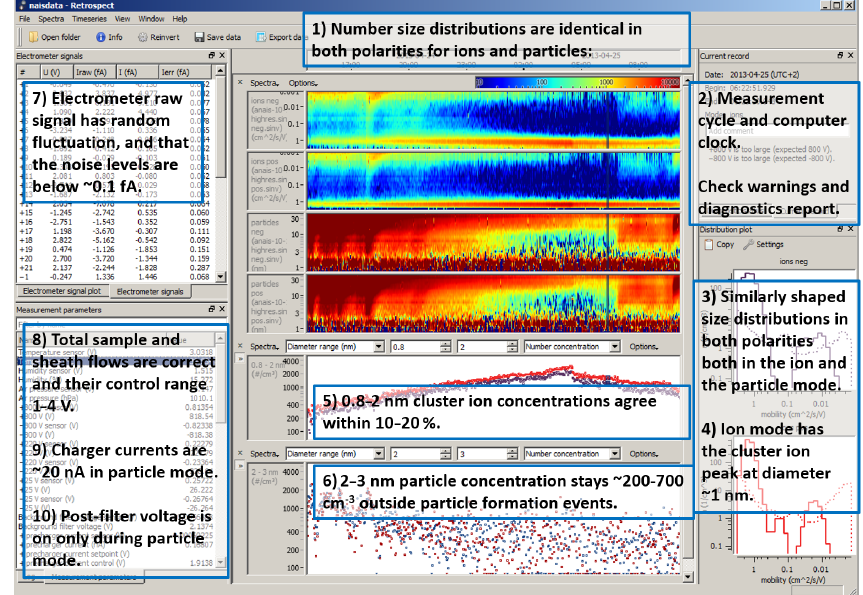
Figure 8. The NAIS measurement software (Spectops.exe or Retrospect.exe) is recommended to be used for checking that the instrument is operating properly by following the steps listed in the